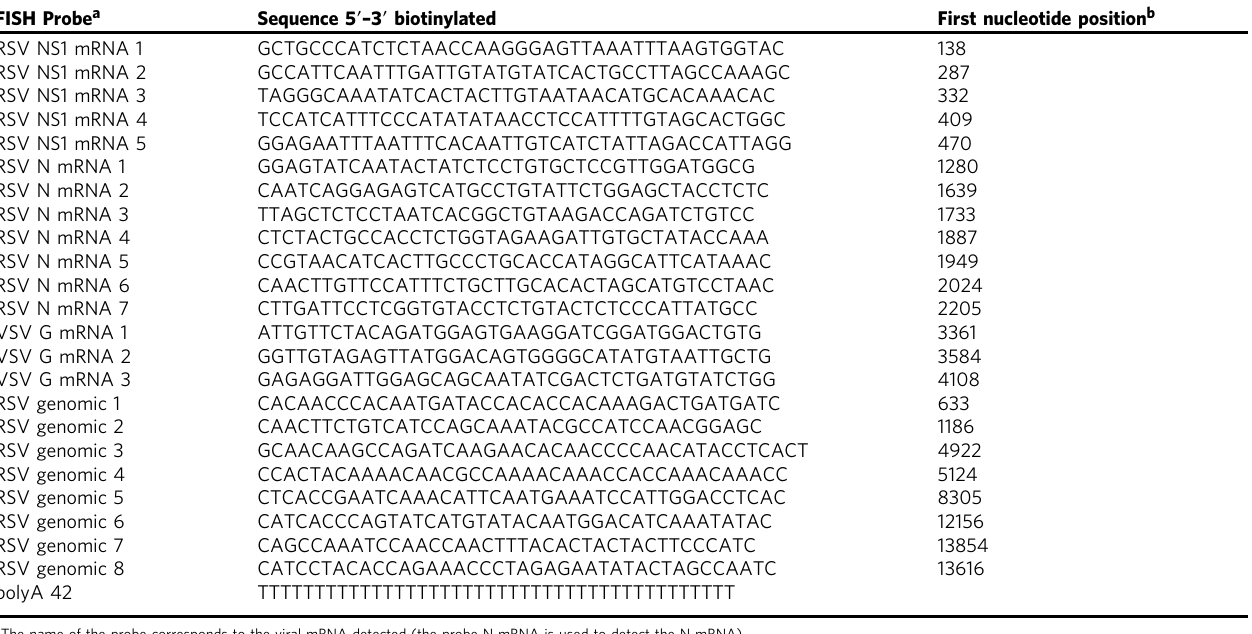
Table 1 Sequences of the probes used in FISH experiments FISH Probe a Sequence 5 ′ – 3 ′ biotinylated